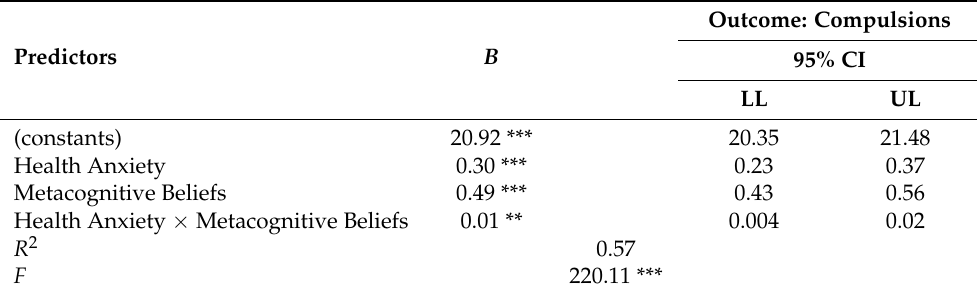
Table 5. Moderation of metacognitive beliefs between health anxiety and compulsions (cyberchondria construct) ( N = 500).